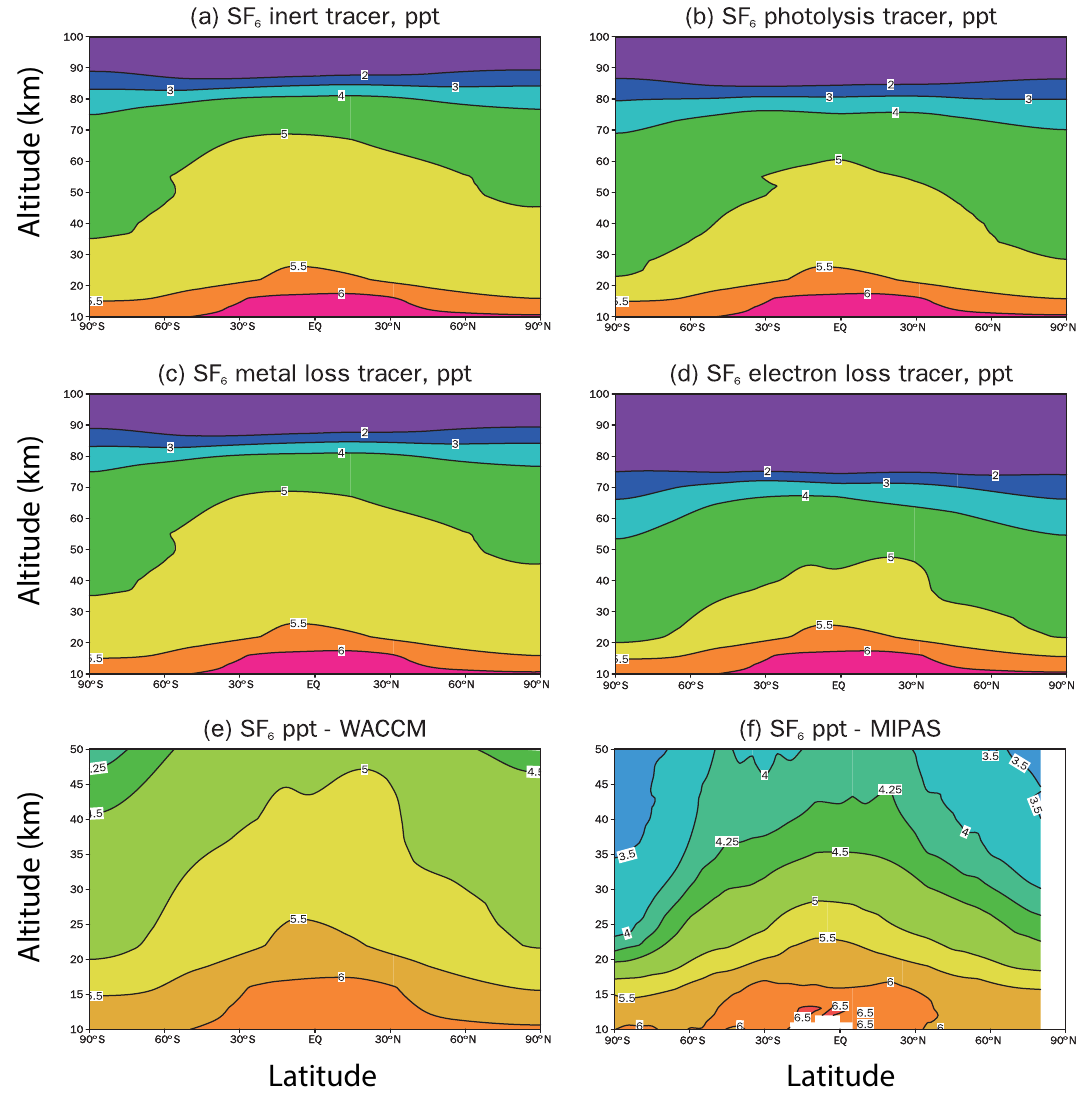
Figure 5. Annual zonal mean latitude–height volume mixing ratios (pptv) of the different WACCM SF 6 tracers in 2007: (a) inert SF 6 tracer; (b) SF 6 tracer removed by photolysis only; (c) SF 6 tracer removed by mesospheric metals only; (d) SF 6 tracer removed by electron attachment only; and (e) total reactive SF 6 . Panel (f) shows the SF 6 volume mixing ratio for 2007 from MIPAS observations. Note the different altitude ranges and contour intervals for panels (a) – (d) versus panels (e) – (f)